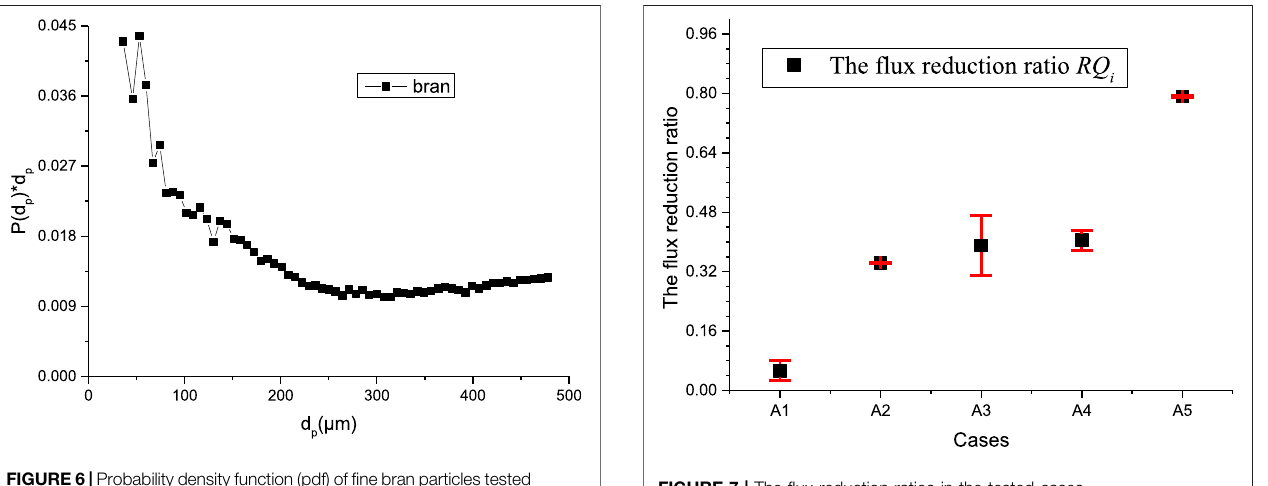
FIGURE 7 | The fl ux reduction ratios in the tested